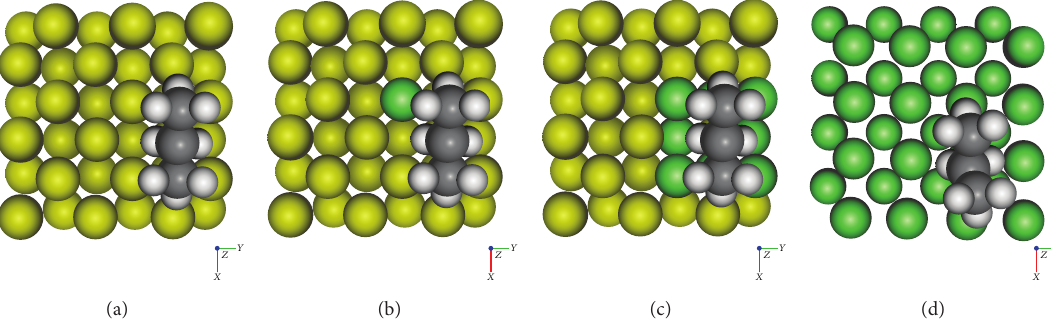
Figure 1: Propane adsorbed on the surface of Ni/Fe alloy anode slab (top view) with compositions of (a) 0% Fe (pure Ni slab), (b) 2.8% Fe, (c) 22.2% Fe, and (d) 100% Fe.